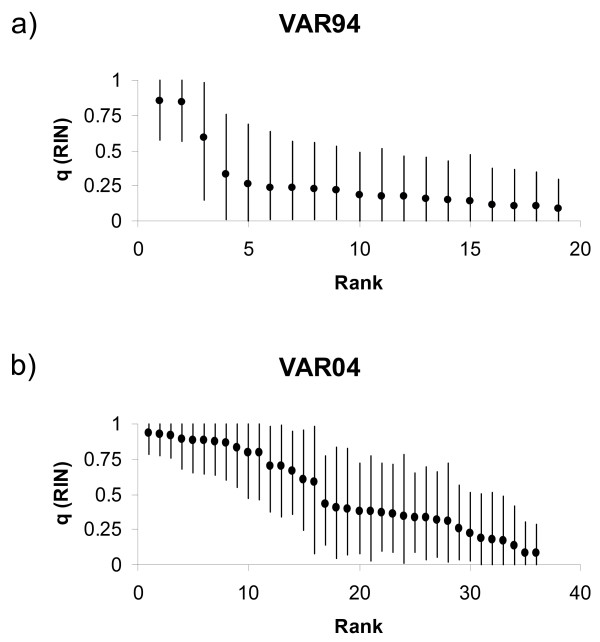
Individual admixture proportions. Individual admixture proportions (q) and their associated 90% credible intervals in the VAR94 and VAR04 samples, estimated using VID (NSH) and RIN (ELW) as learning samples. A q value of 1 denotes a "pure" RIN individual, and conversely 0 denotes a "pure" VID individual. q values were ranked from lowest to highest. The analyses were conducted using STRUCTURE 2.2 [51,52]. a) q values in the VAR94 sample. b) q values in the VAR04 sample.